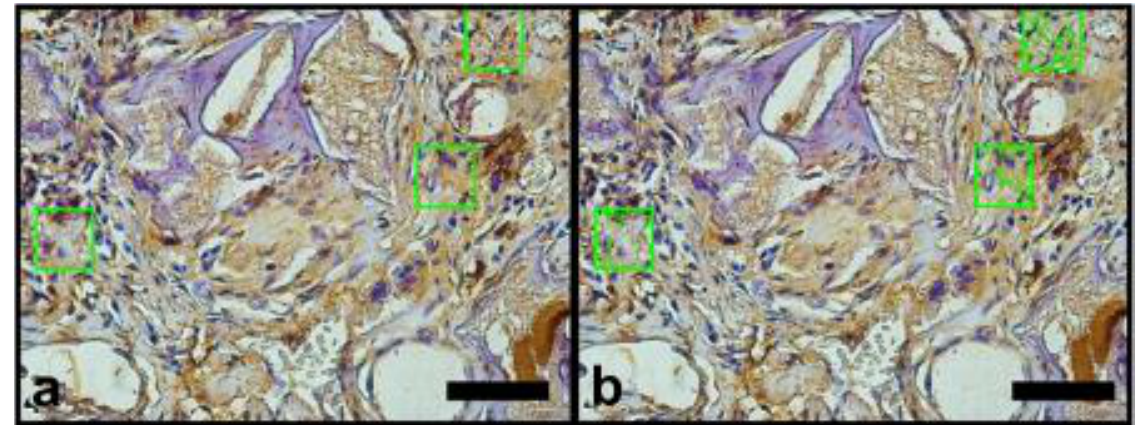
Figure 4. Photomicrographs of immunohistochemistry for VEGF, quantification of the area of interest of the immunostained slides for VEGF (×40 magnification) (100 µm scale bar). ( a ) Green square areas limited the quantification sites randomly selected. ( b ) Green dotted area inside green square indicates the Image Pro Plus 7.0 software identification of the brownish color of the DAB deposits.